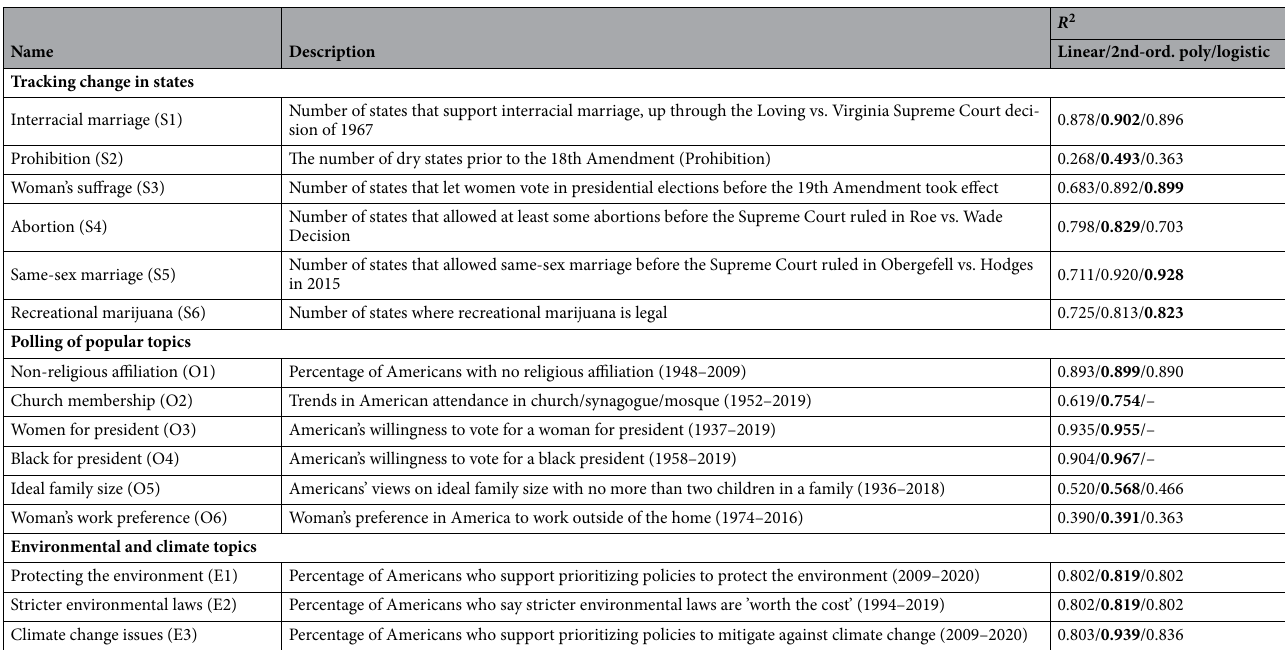
Table 1. Gallup polls 19 showing social positions, environmental and climate data 21 along with R 2 fit values. The best fits are in bold.